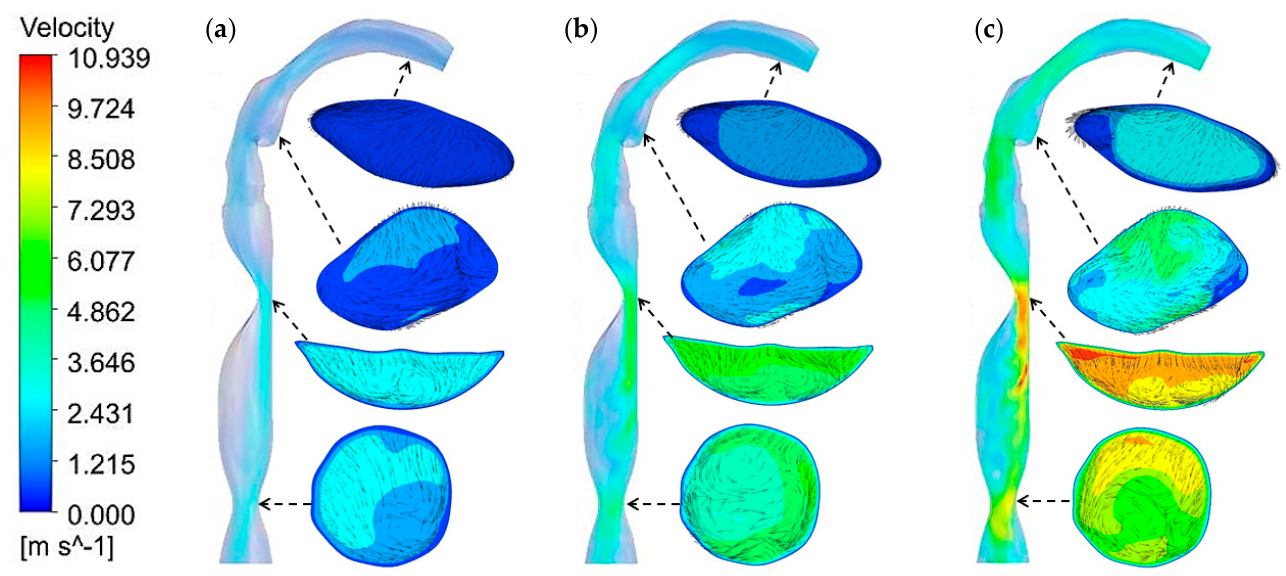
Figure 5. Velocity fields and velocity contours at four selected locations, namely, the mouth, throat, trachea with stenosis 75% and 50% reductions, at ( a ) 7.5 L/min; ( b ) 15 L/min; and ( c ) 25 L/min.